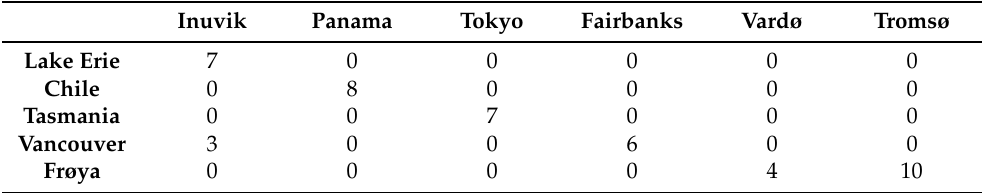
Table 2. Count of first ground station used after each target for the simulated